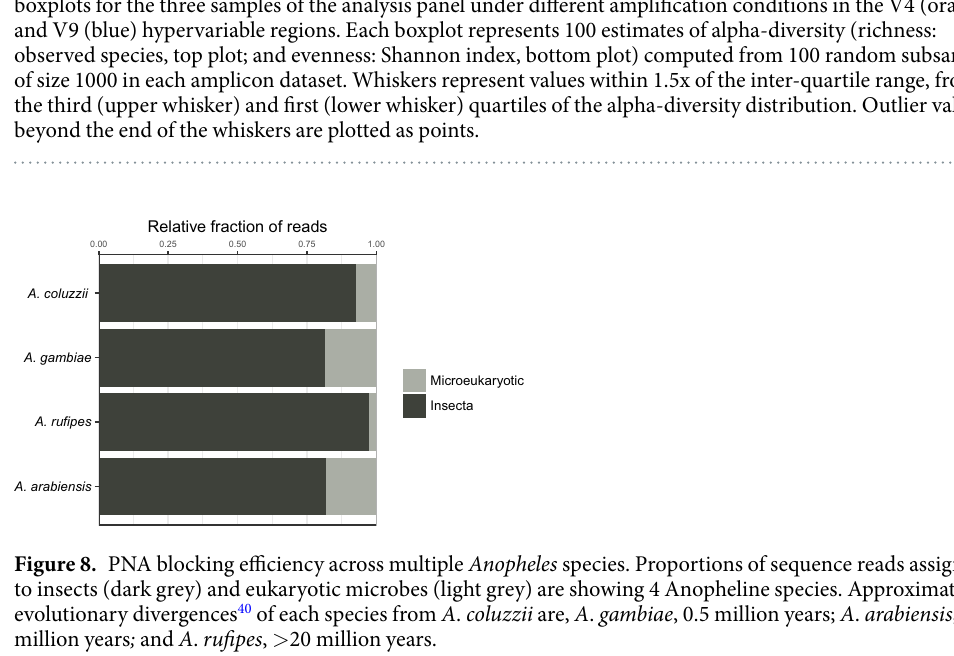
of mosquito host 18s rRNA gene amplification, allowing emergence of the eukaryotic microbial community sig- nal, without effect on the relative proportions of the lineages in the larval community. PNA blocking in other Anopheles species. To determine the generality of these tested PNA blockers for use in species other than A . coluzzii , we empirically tested blocking efficiency for the V9 region of the 18S rRNA gene using test sets of larval samples for three other Anopheles species (Fig. 8). Two of these species are also within the A . gambiae species complex ( A . gambiae and A . arabiensis) , and the third species, A . rufipes , is outside of the A . gambiae species complex. Evolutionary divergence from A . coluzzii is approximately 0.5 million years for A . gambiae , 1.8 million years for A . arabiensis , and more than 20 million years for A . rufipes 40 . While the degree of observed PNA blocking efficiency was variable across species, in all cases the blocking was efficient enough to yield sequence reads for assessment of the eukaryotic microbiome on a comparable level as the blocking observed for A . coluzzii (Fig. 8). Thus, the PNA blocker AgV9-PNA can be expected to efficiently block host 18s rRNA gene amplification from both closely related as well as more distant Anopheles taxa.